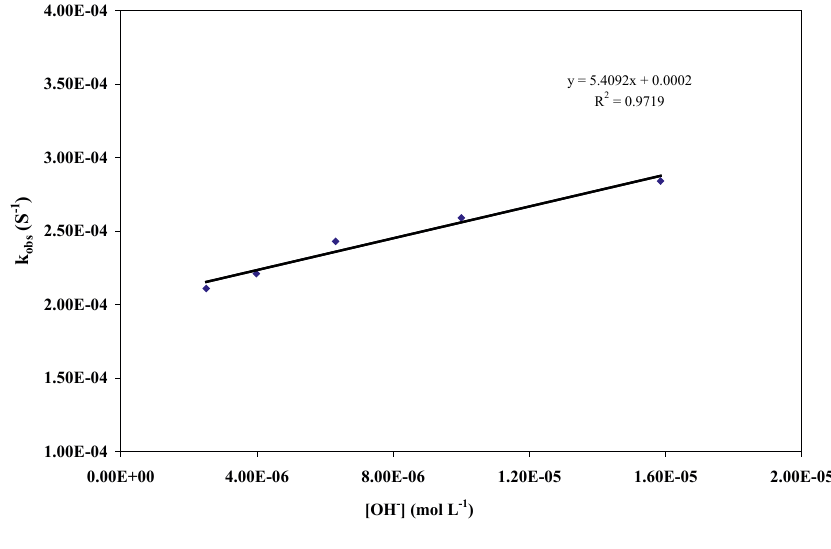
for the hydrolysis of glycine methyl ester coordinated to Pd(pip) complex at 25°C obs